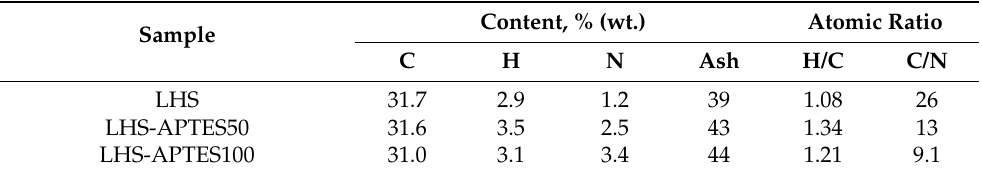
Table 1. Some characteristics of element composition of the leonardite humic